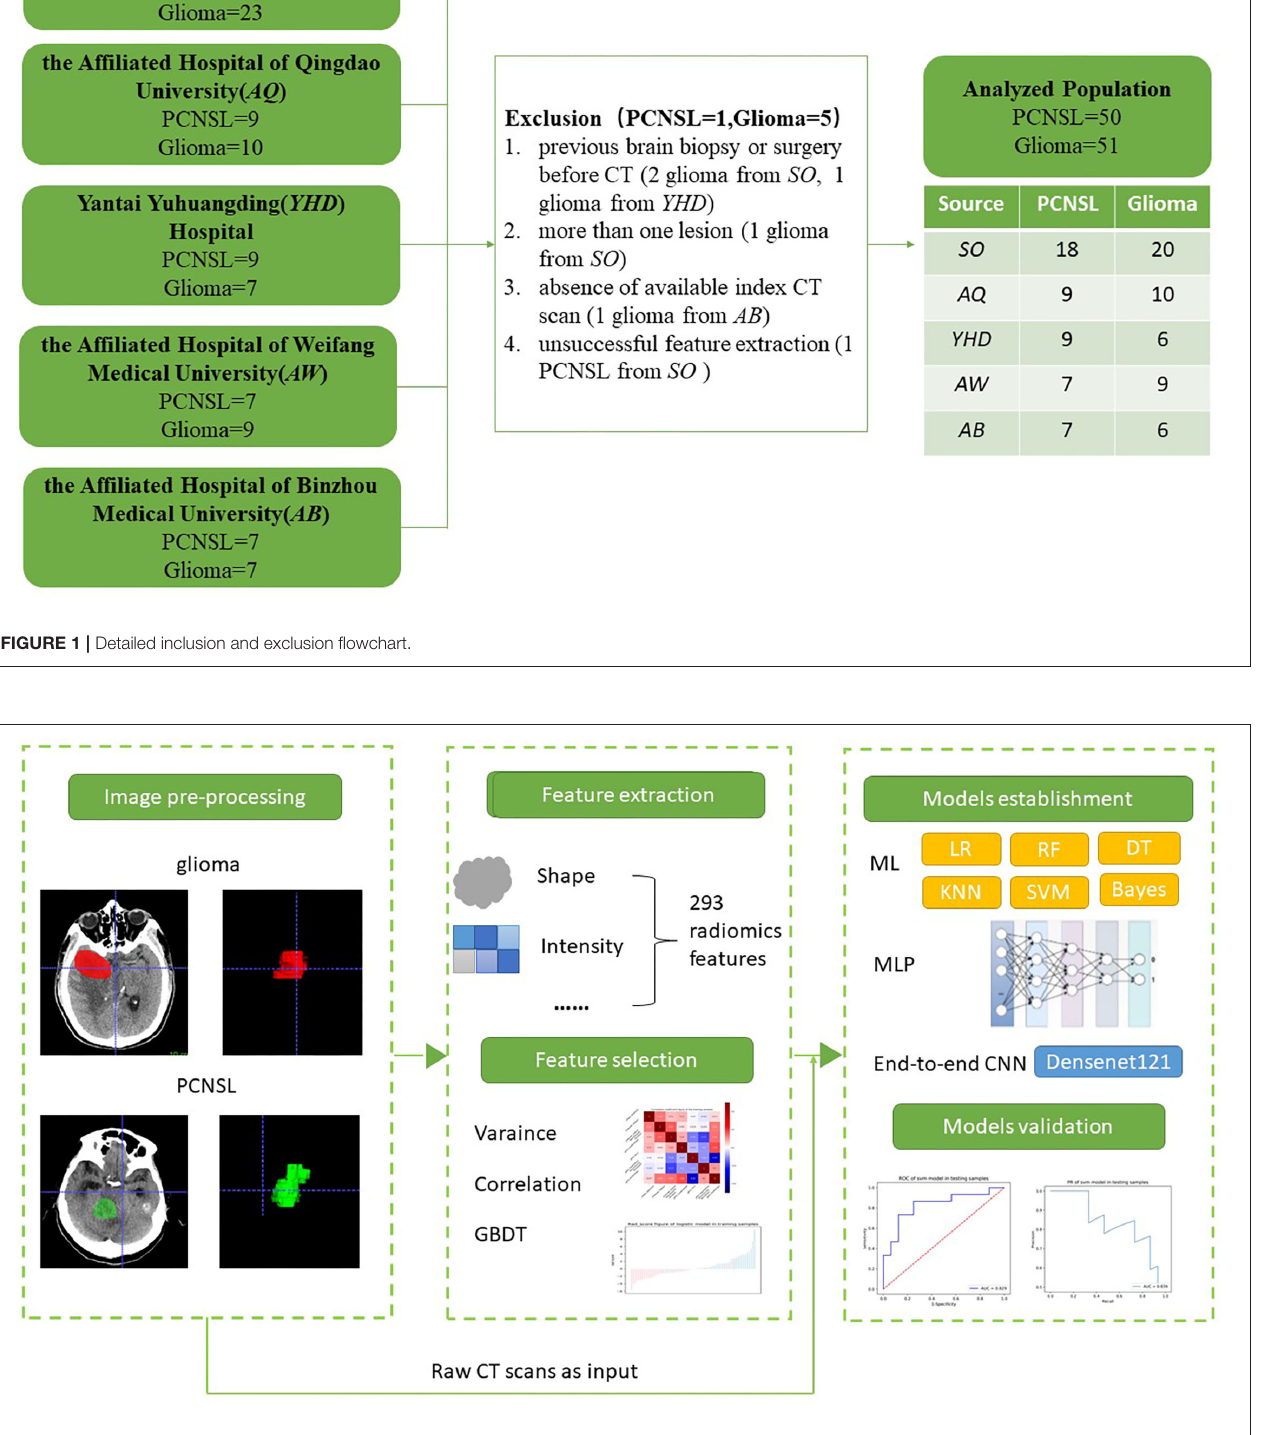
FIGURE 2 | The workflow of this study. (1) Image processing, (2) feature extraction, (3) machine learning and deep learning for differentiation PCNSL from glioma.